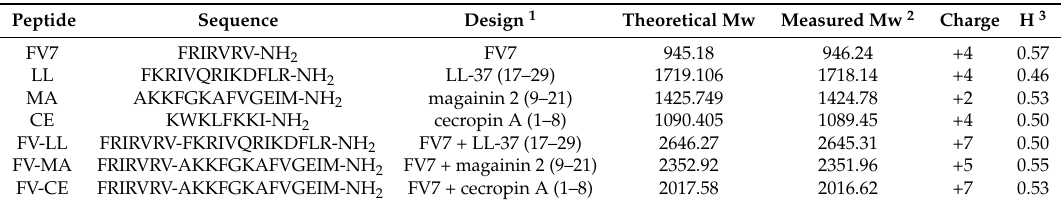
Table 1. Amino acid sequences, design, molecular weights, net charges and hydrophobicity values of the peptides used in this study.